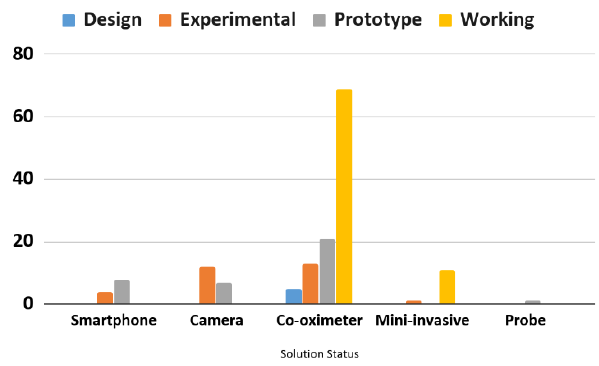
Figure 15. Device Type vs. Solution